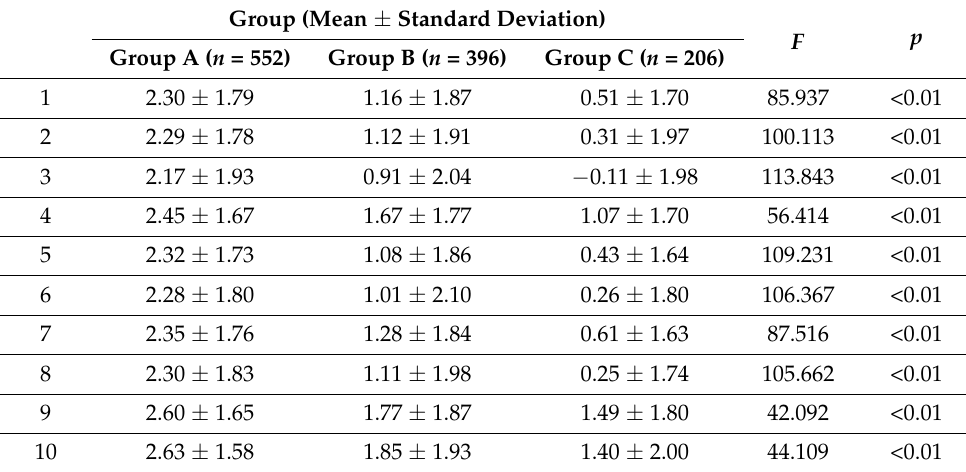
Table 4. Analysis of